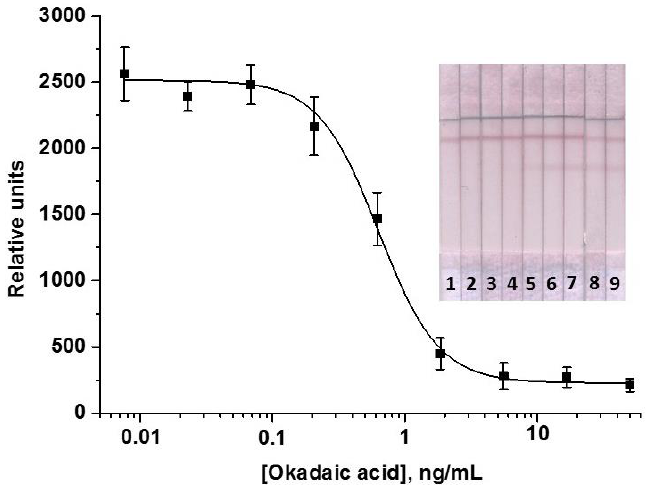
Figure 3. Calibration curve of OA in the LFIA ( n = 3) and the corresponding test strips. Concentrations of OA were 50 ng/mL (1); 16.7 ng/mL (2); 5.6 ng/mL (3); 1.9 ng/mL (4); 0.62 ng/mL (5); 0.21 ng/mL (6); 69 ng/mL (7); 23 pg/mL (8); 7.6 pg/mL